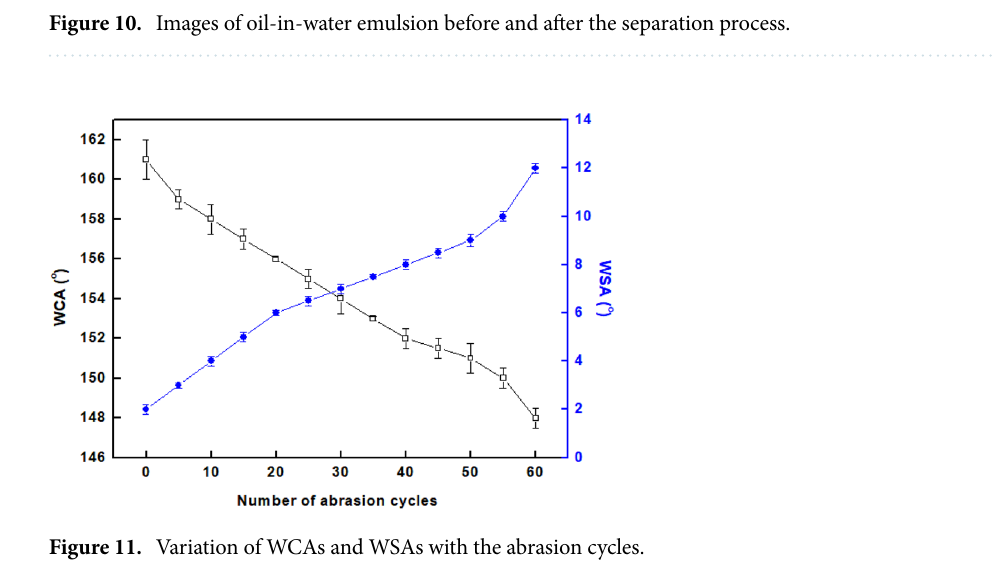
Figure 11. Variation of WCAs and WSAs with the abrasion